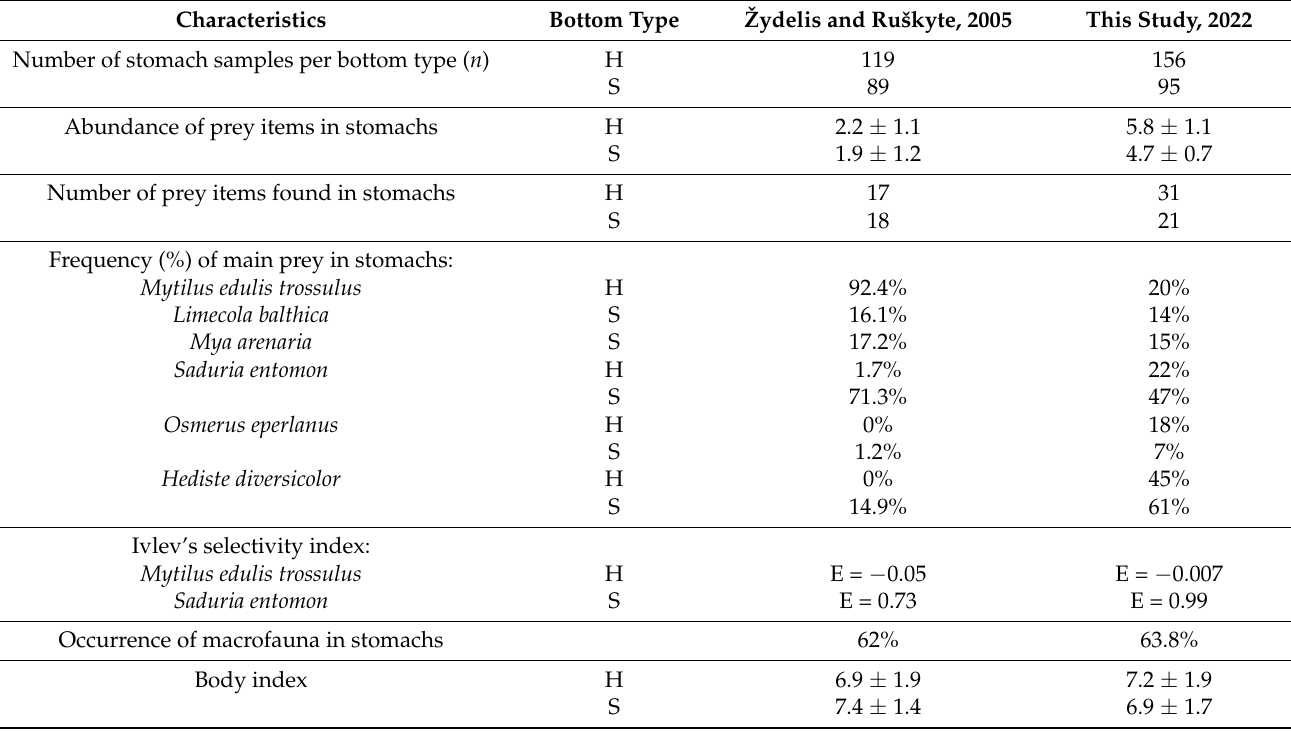
Table 5. Comparison of the long-tailed duck diet characteristics analysed in this study and Žydelis and Ruškyte (2005). Bottom type divided in hard-bottom (H) and soft-bottom (S). Characteristics Bottom Type Žydelis and Ruškyte, 2005 This Study,